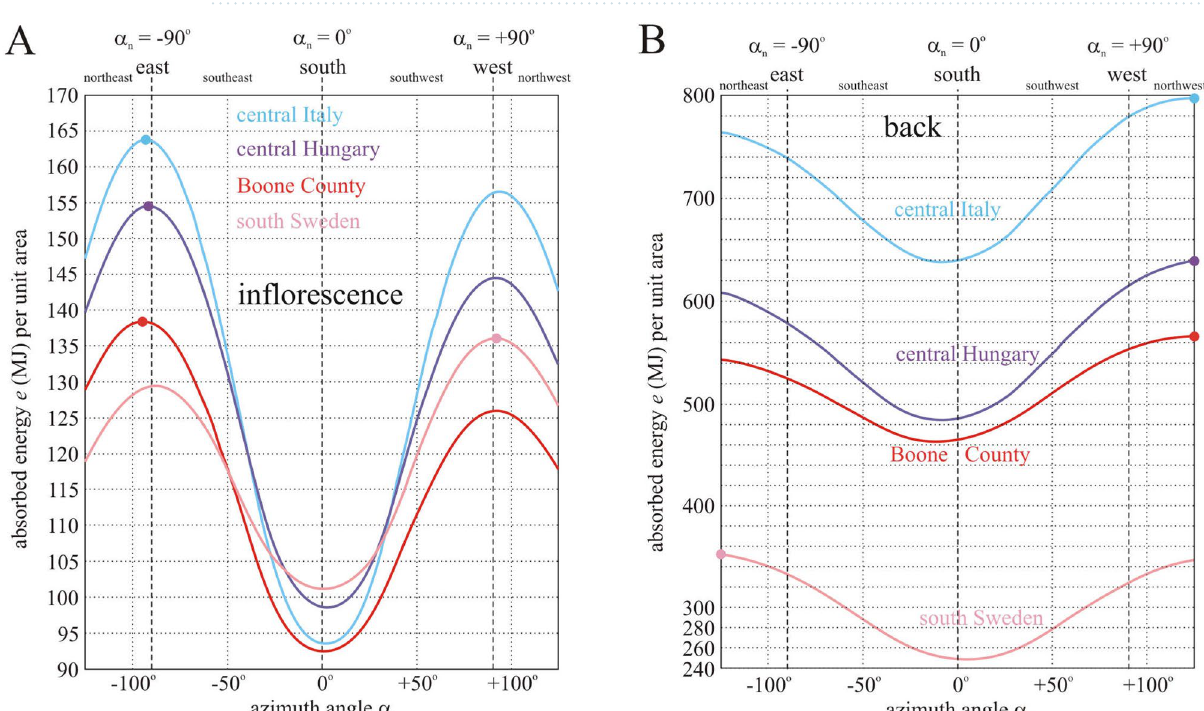
Figure 4. Absorption spectra of sunflower heads. Average absorption spectra A (λ) of young (2 weeks) and old (4 weeks) inflorescence ( A ) and back ( B ) of sunflower heads, where λ is the wavelength of light.